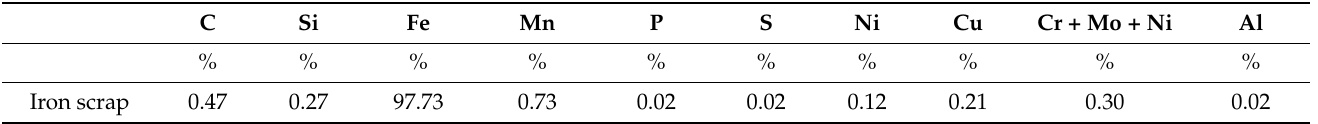
Table 14. Chemical composition of iron